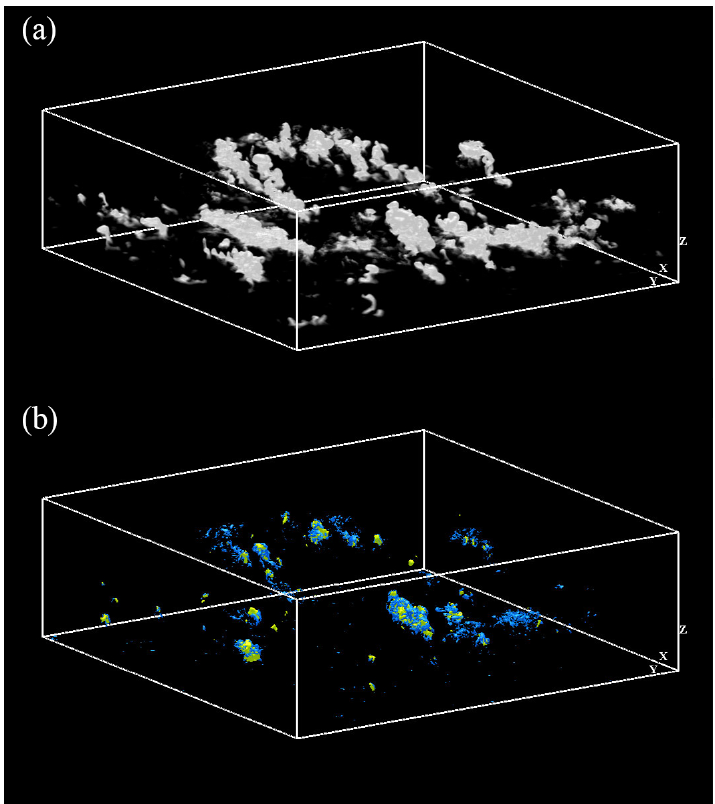
Figure 8. Three-dimensional visualization of cloud simulation data: (a) volume rendering of optical depth and (b) isosurfaces of (blue) the energy dissipation rate (cid:15) = 100cm 2 s − 3 and (yellow) the vertical velocity u 3 = 3ms − 1